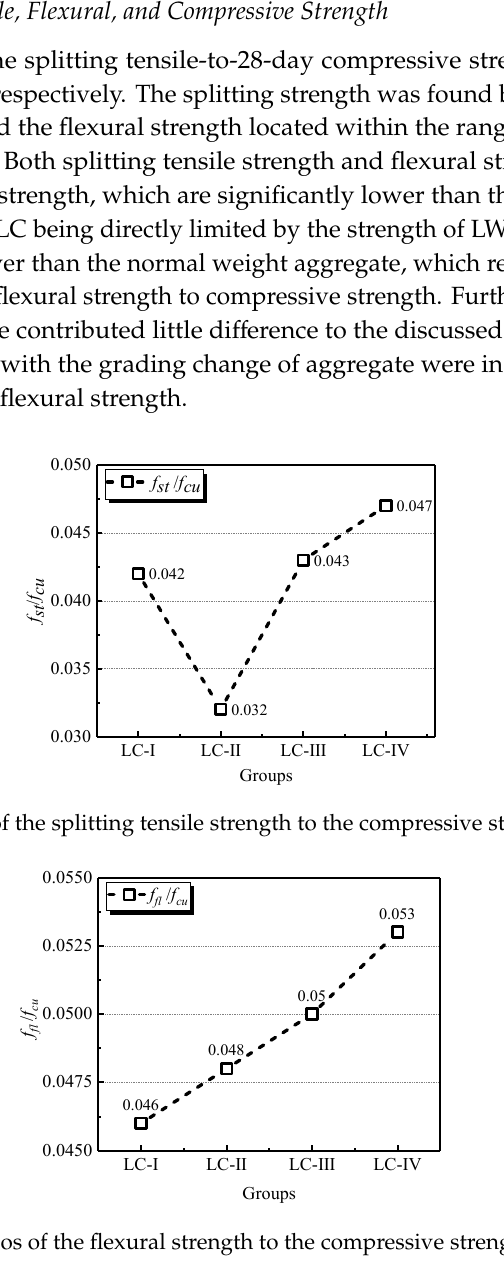
Figure 6. Ratios of the flexural strength to the compressive strength of LC.